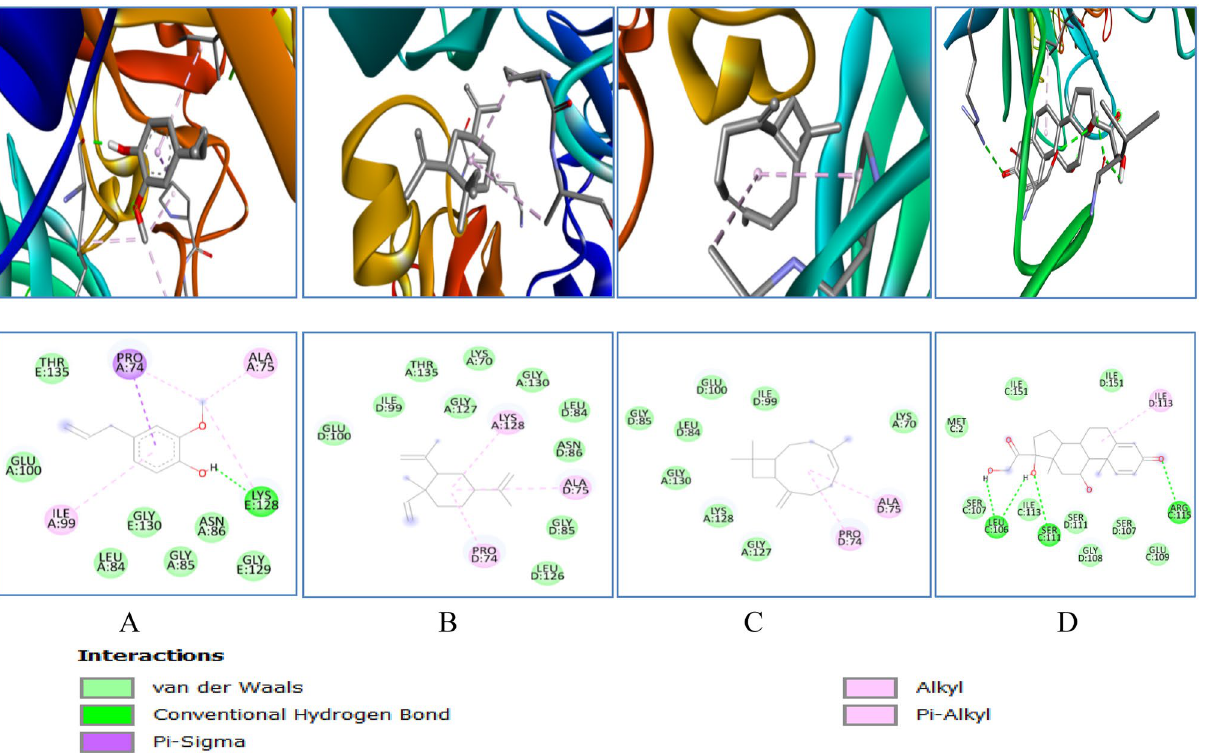
Figure 10. 3D (to the upper panel) and 2D (to the lower panel) interaction diagrams of ( A ) Eugenol, ( B ) Cyclohexane ( C ) Caryophyllene, ( D ) Prednisolone with the crystal structure of SOD (PDB ID: 3GTT).